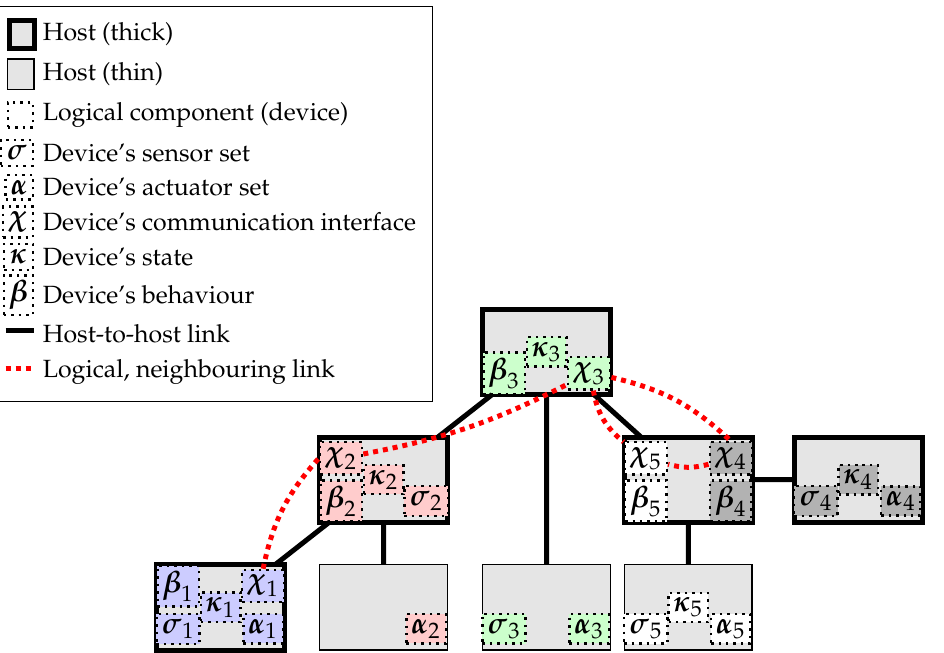
Figure 3. Example instantiation of the CPS model. Dotted graphical elements denote logical components/connections, while solid-line elements denote platform or physical components/connections. Different subscripts (or colors) map to different logical devices. Intra-device connections (Figure 2) are not shown but they can cross host boundaries by following direct host-level links.